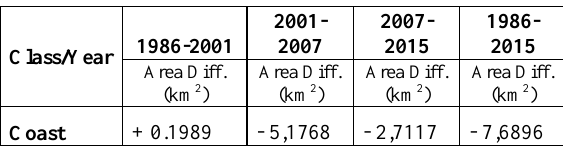
Table 3: The area diferences for the coast between 1986-2015 Besides, coastal deformation in 1986, the total area of urban was equaled to 6.8877 km 2 while in 2007 the total area of the same class was equaled to 20.5227km 2 . In Table 4, all classes producer and user accuracies are displayed for the